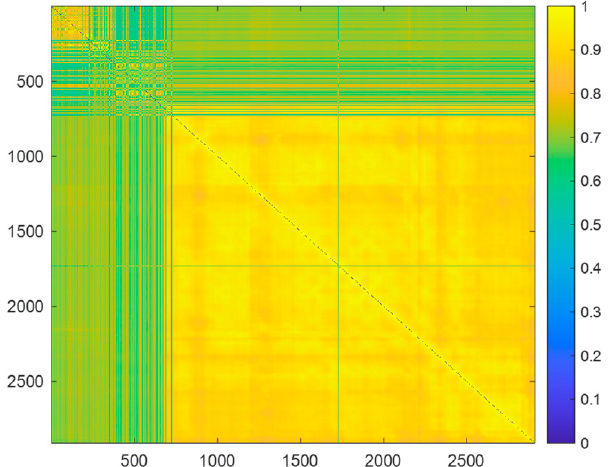
Figure 13. Similarity matrix of pulse time-frequency images in the measured data.